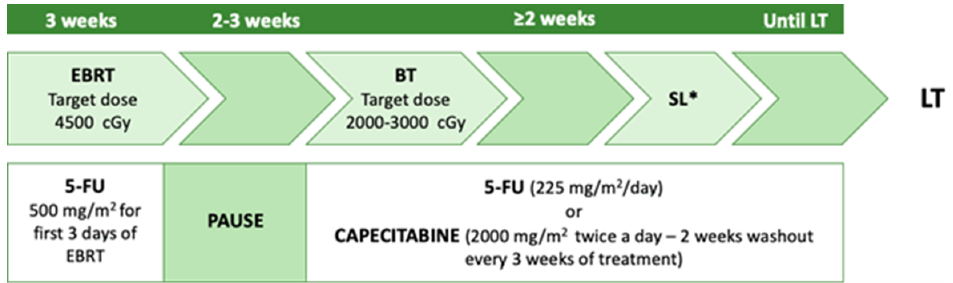
Figure 3. Mayo Clinic neoadjuvant protocol. EBRT: external beam radiotherapy; BT: brachytherapy; SL: staging laparotomy; LT: a liver transplant. * with biopsies of at least common hepatic artery and distal bile duct lymph nodes.